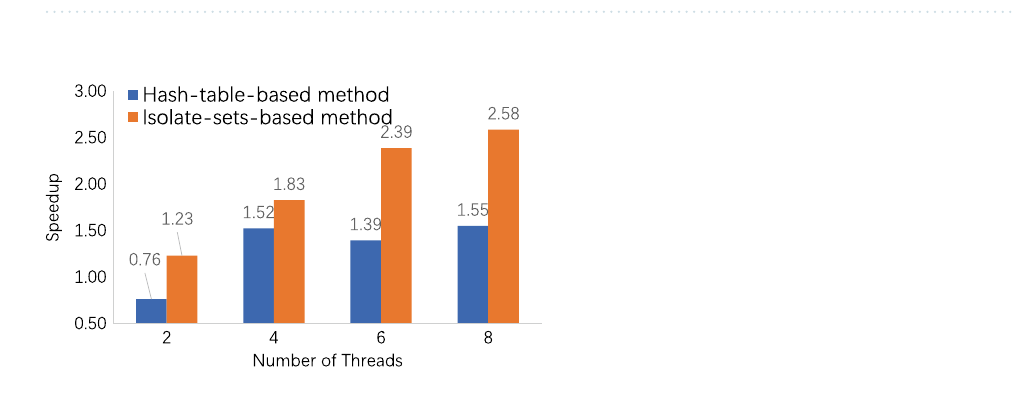
Figure 1. Speedup on dataset LiveJournal. The speedup of our method is higher than hash-table-based method with 8 threads.